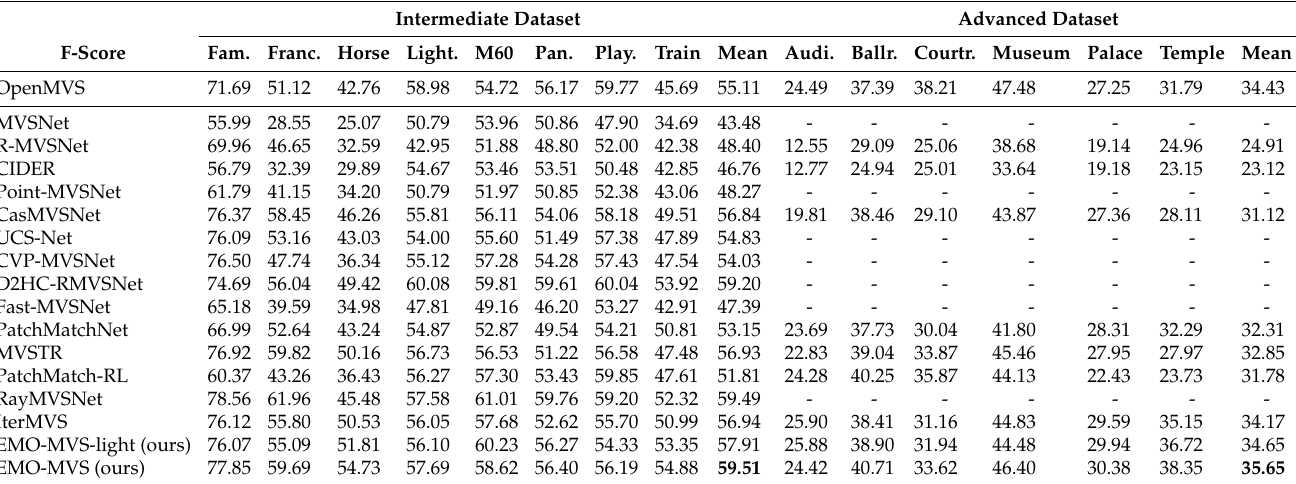
Table 3. Quantitative results of different methods on the Tanks and Temples benchmark. ’Mean’ refers to the mean F-score of all scenes ( ↑ ). Bold font represents the best.